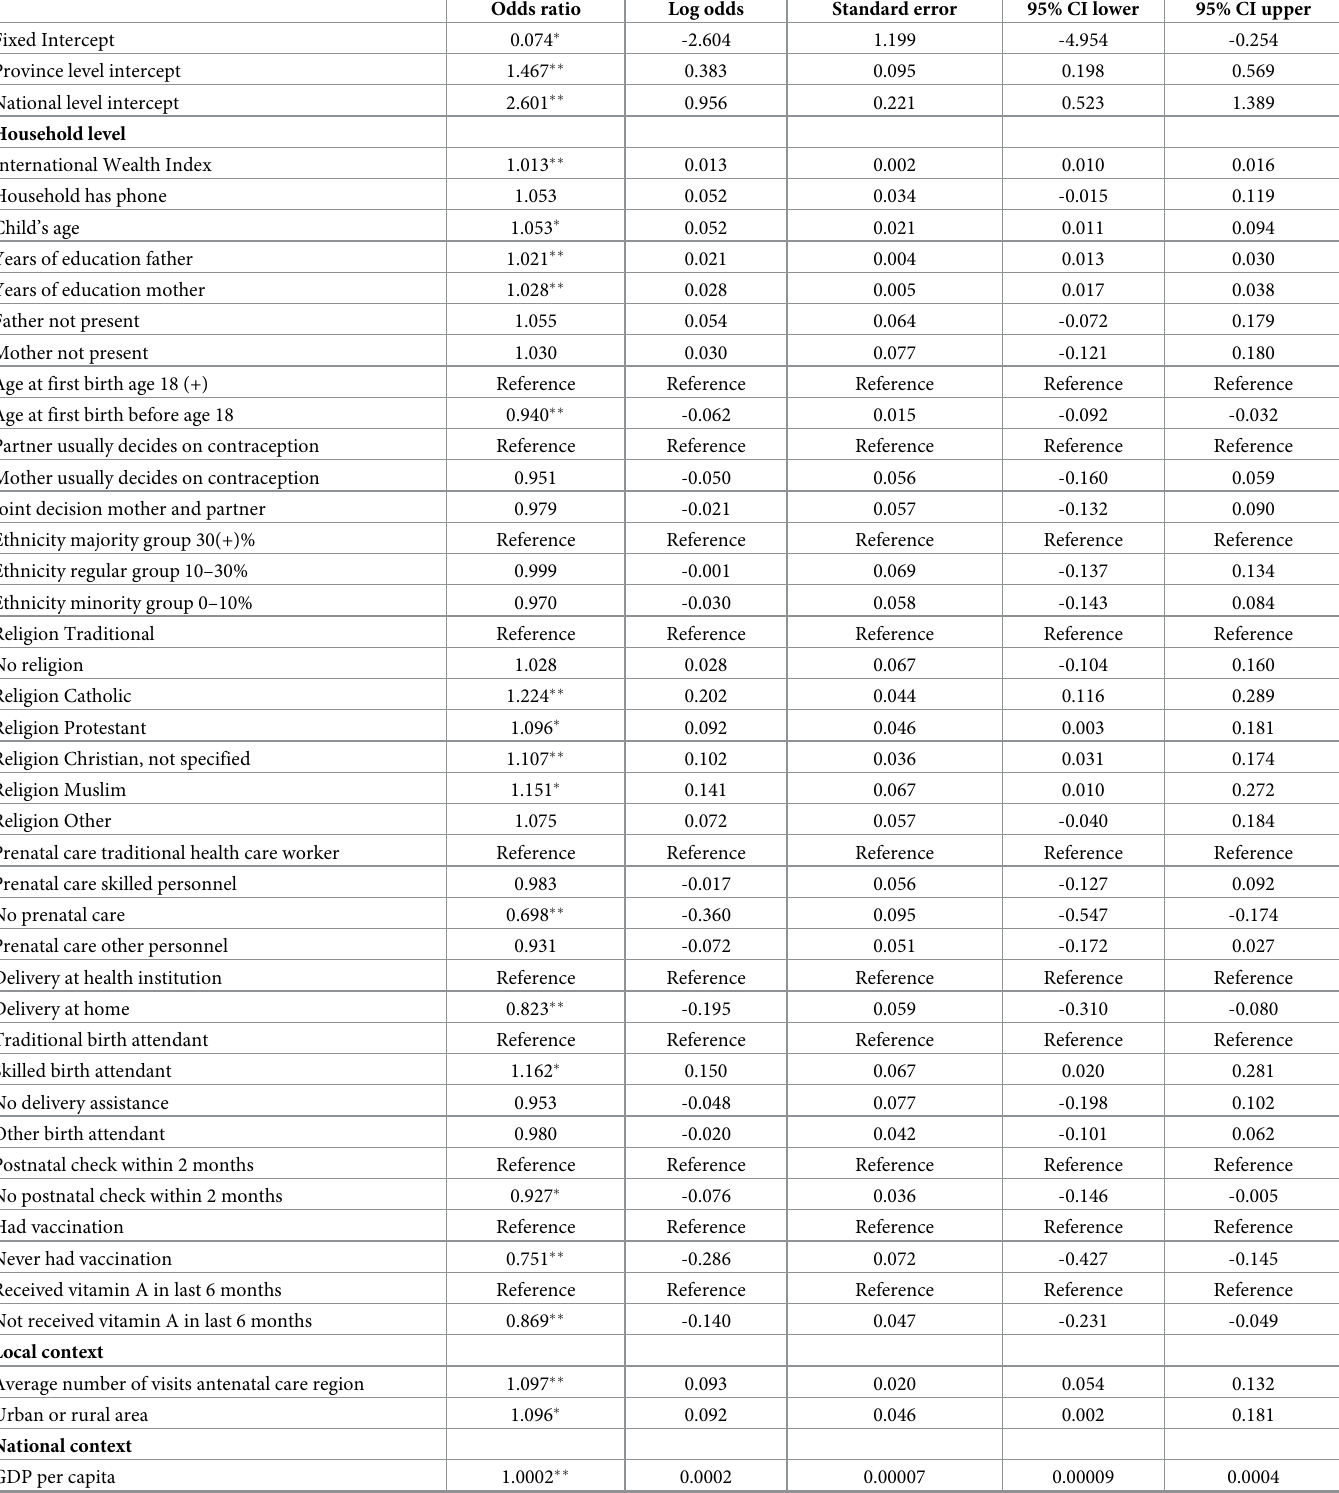
Table 1. Logistic fixed effects models with random intercepts a